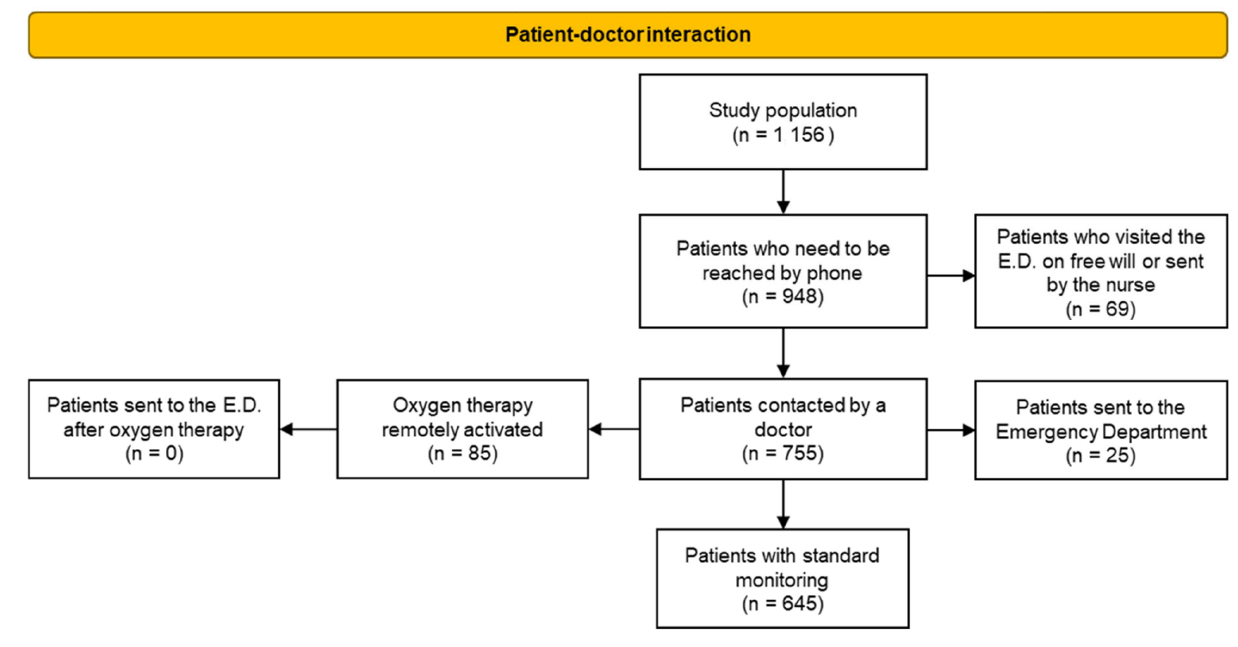
Figure 8. Patient ‐ doctor interaction. Figure 8. Patient-doctor